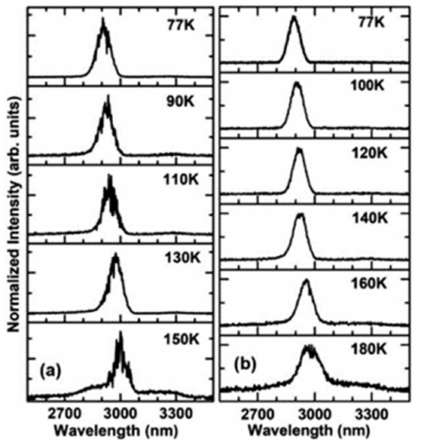
Figure 26. Temperature-dependent lasing spectra for a bulk GeSn laser with an Sn content of up to 22.3%; the optical injection sources were ( a ) a 1064 nm pulsed laser and ( b ) a 1950 nm pulsed laser. Reproduced from [75], OSA Publishing, open access,